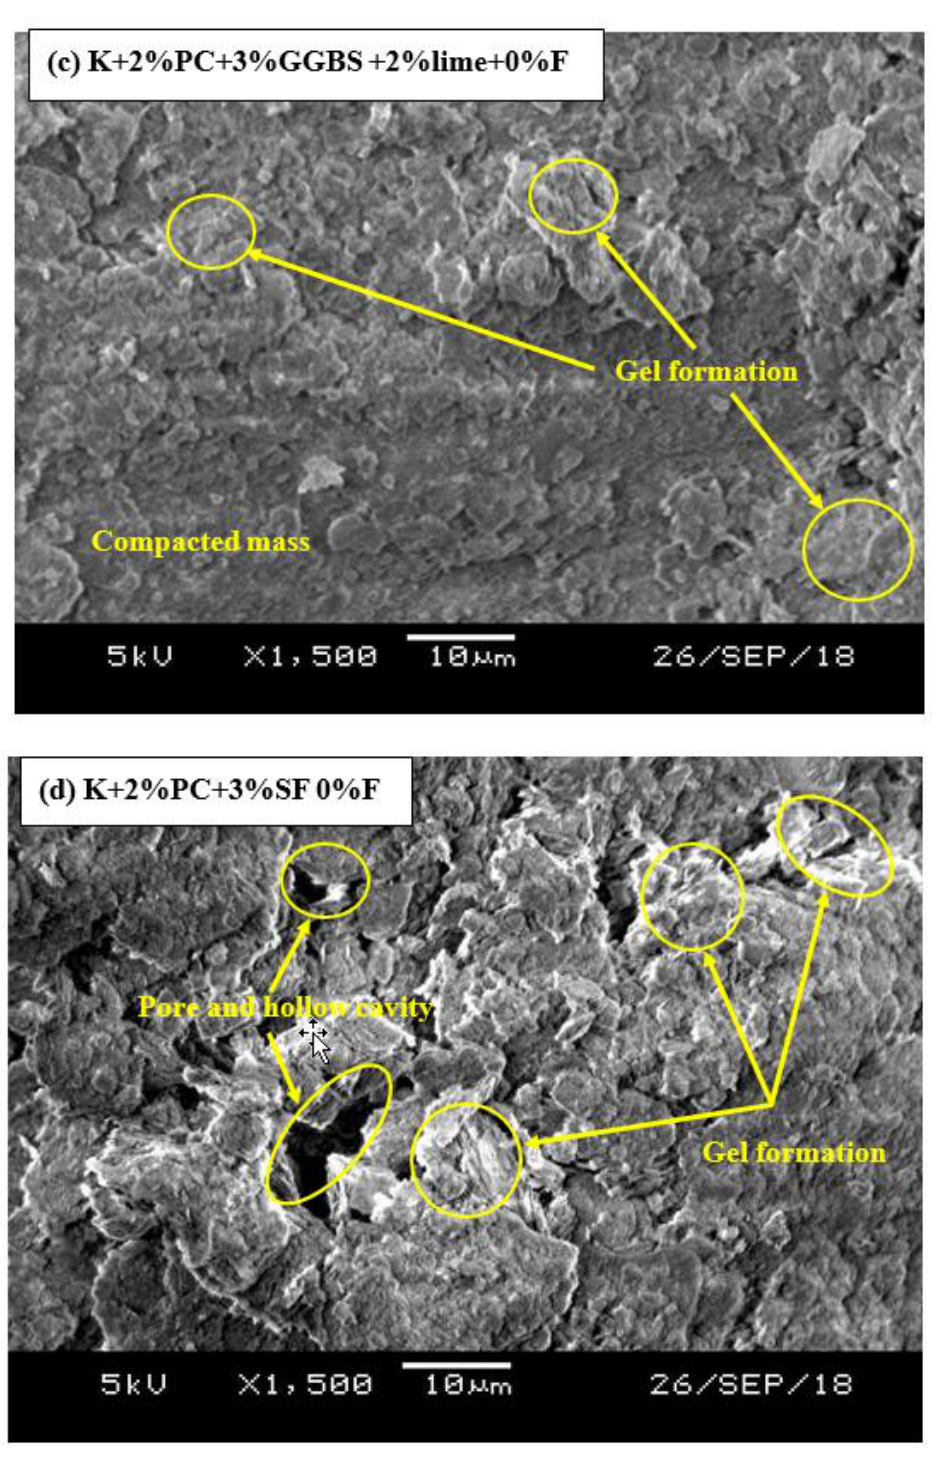
Figure 10. ( a – d ) SEM images of fibre-reinforced clay blended with PC and SCM.